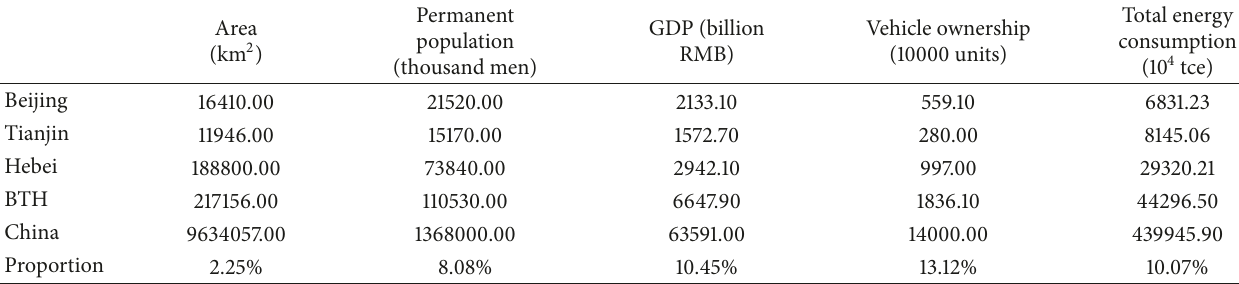
Table 2: Some Information about the Beijing-Tianjin-Hebei region in